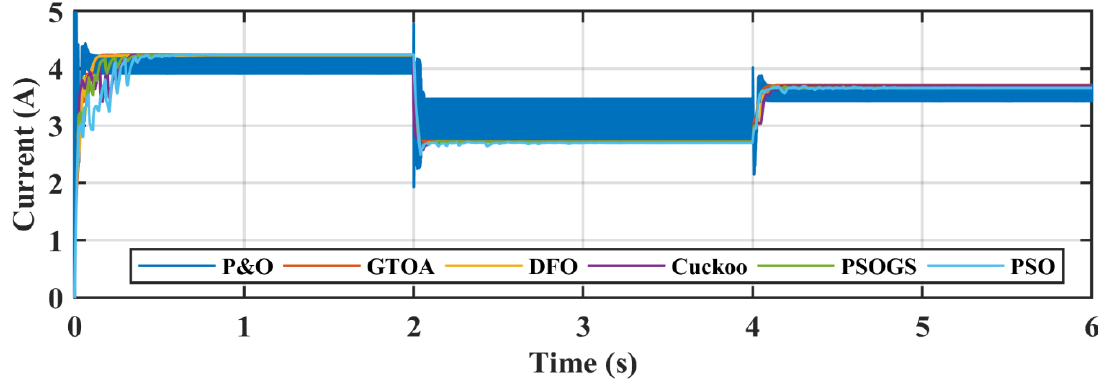
Figure 14. Comparison of current transients of GTOA.